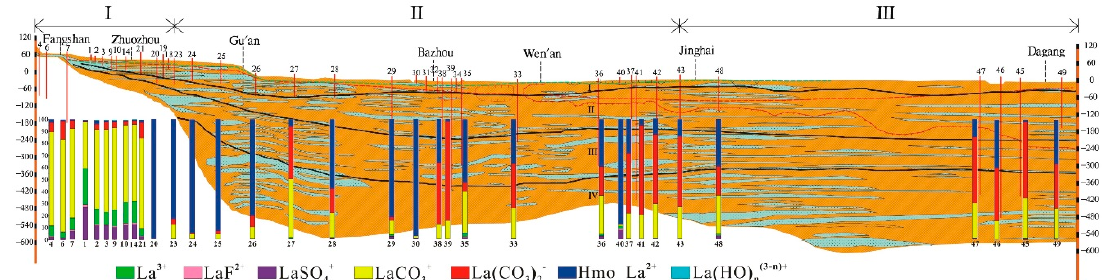
Figure 6. Speciation of groundwater La and its proportion of binding with hydrous manganese oxyhydroxides (HMO) as a function of distance from the charge area.